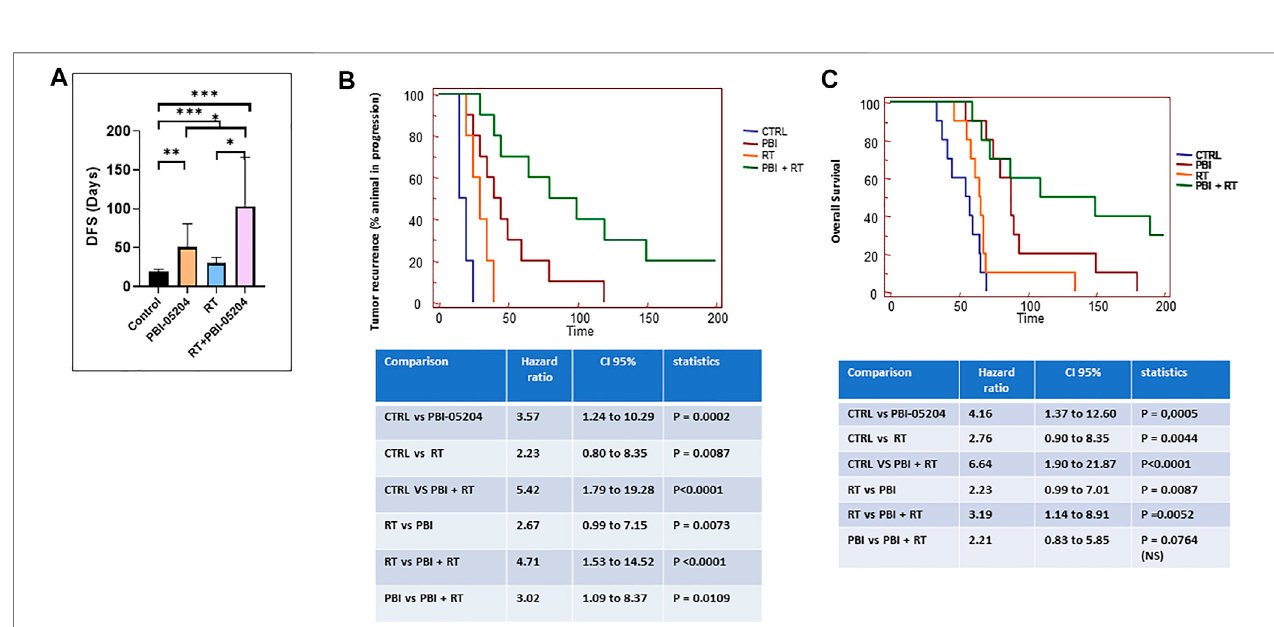
FIGURE 8 | PBI-05204 enhanced the antitumor ef fi cacy of RT in human U87MG-Luc mouse orthotopic model. (A) Disease free survival (DFS) of U87-Luc tumor. * p < 0.05, ** p < 0.01, *** p < 0.001. (B) Kaplan Meyer curves and statistical analyses of tumor recurrence. (C) Kaplan Meyer curves and statistical analyses of overall respectively ( p < 0.0001) ( Figure 7D ). Tumor weight data derived from mice bearing TG98 xenografts showed a similar enhanced response to PBI-05204 plus radiotherapy compared to either